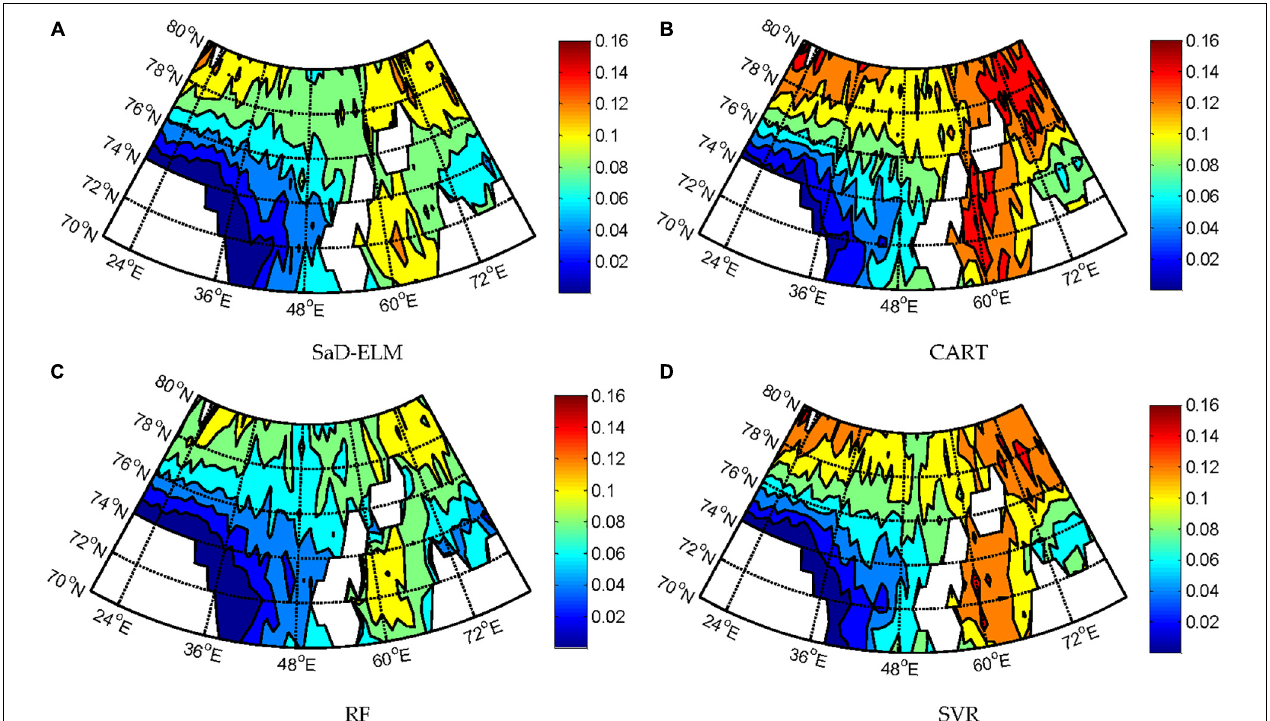
FIGURE 8 | RMSE of predicted SIC at each grid point of B-K sea with four models (lead time = 1 day). (A) SaD-ELM. (B) CART. (C) RF. (D) SVR.